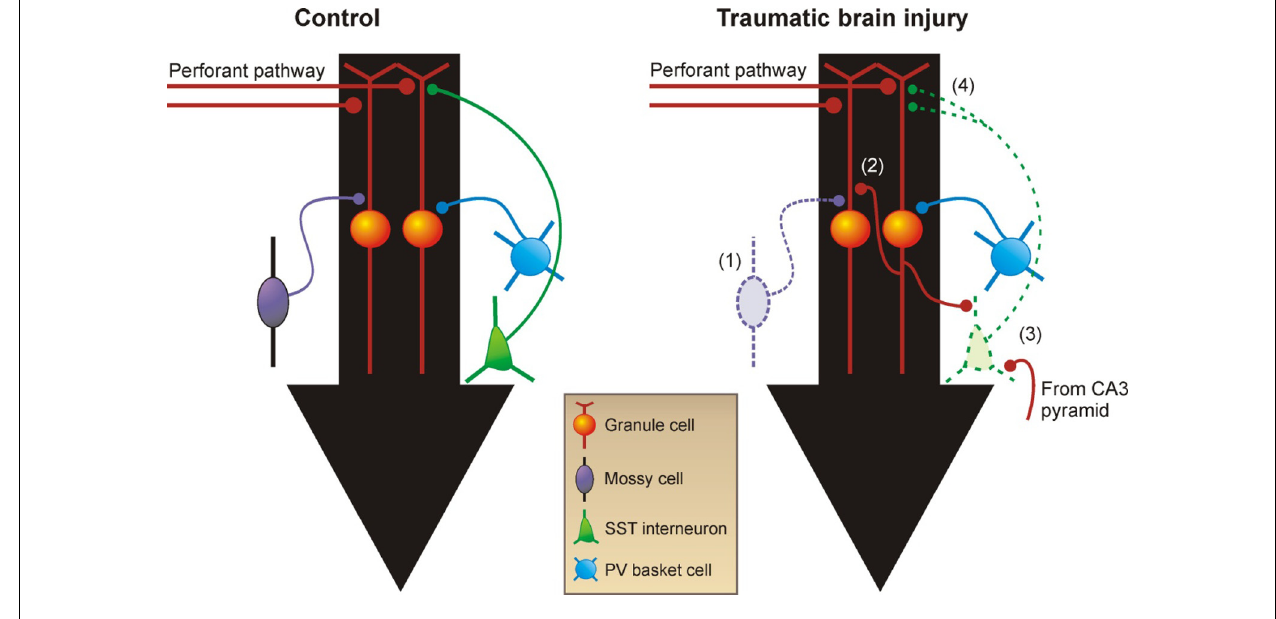
FIGURE 2 | Reorganization of neural circuitry in the dentate gyrus after brain injury. (1)Within days after injury, there are fewer excitatory mossy cells and inhibitory GABA neurons in the hilus. (2)Within weeks afterTBI, mossy fibers sprout axon collaterals into the inner molecular layer and form new recurrent excitatory circuits among granule cells.